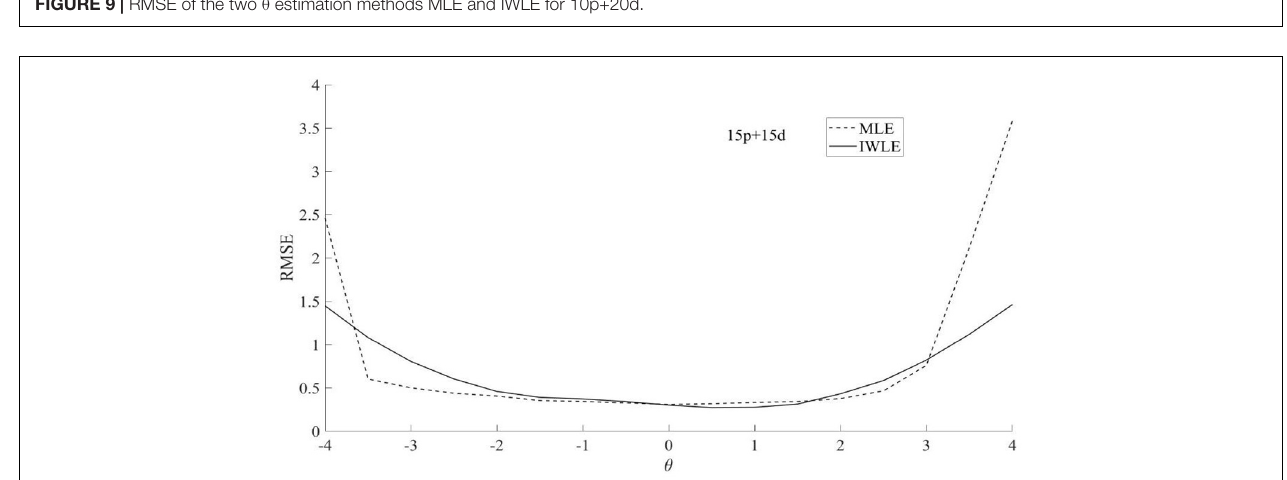
FIGURE 9 | RMSE of the two θ estimation methods MLE and IWLE for 10p+20d.